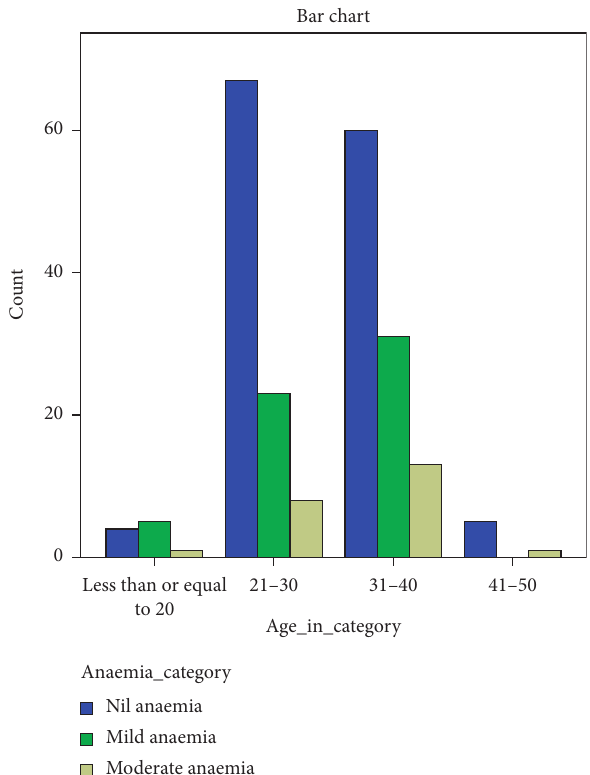
Figure 2: Age-based distribution of anaemia according to its severity.